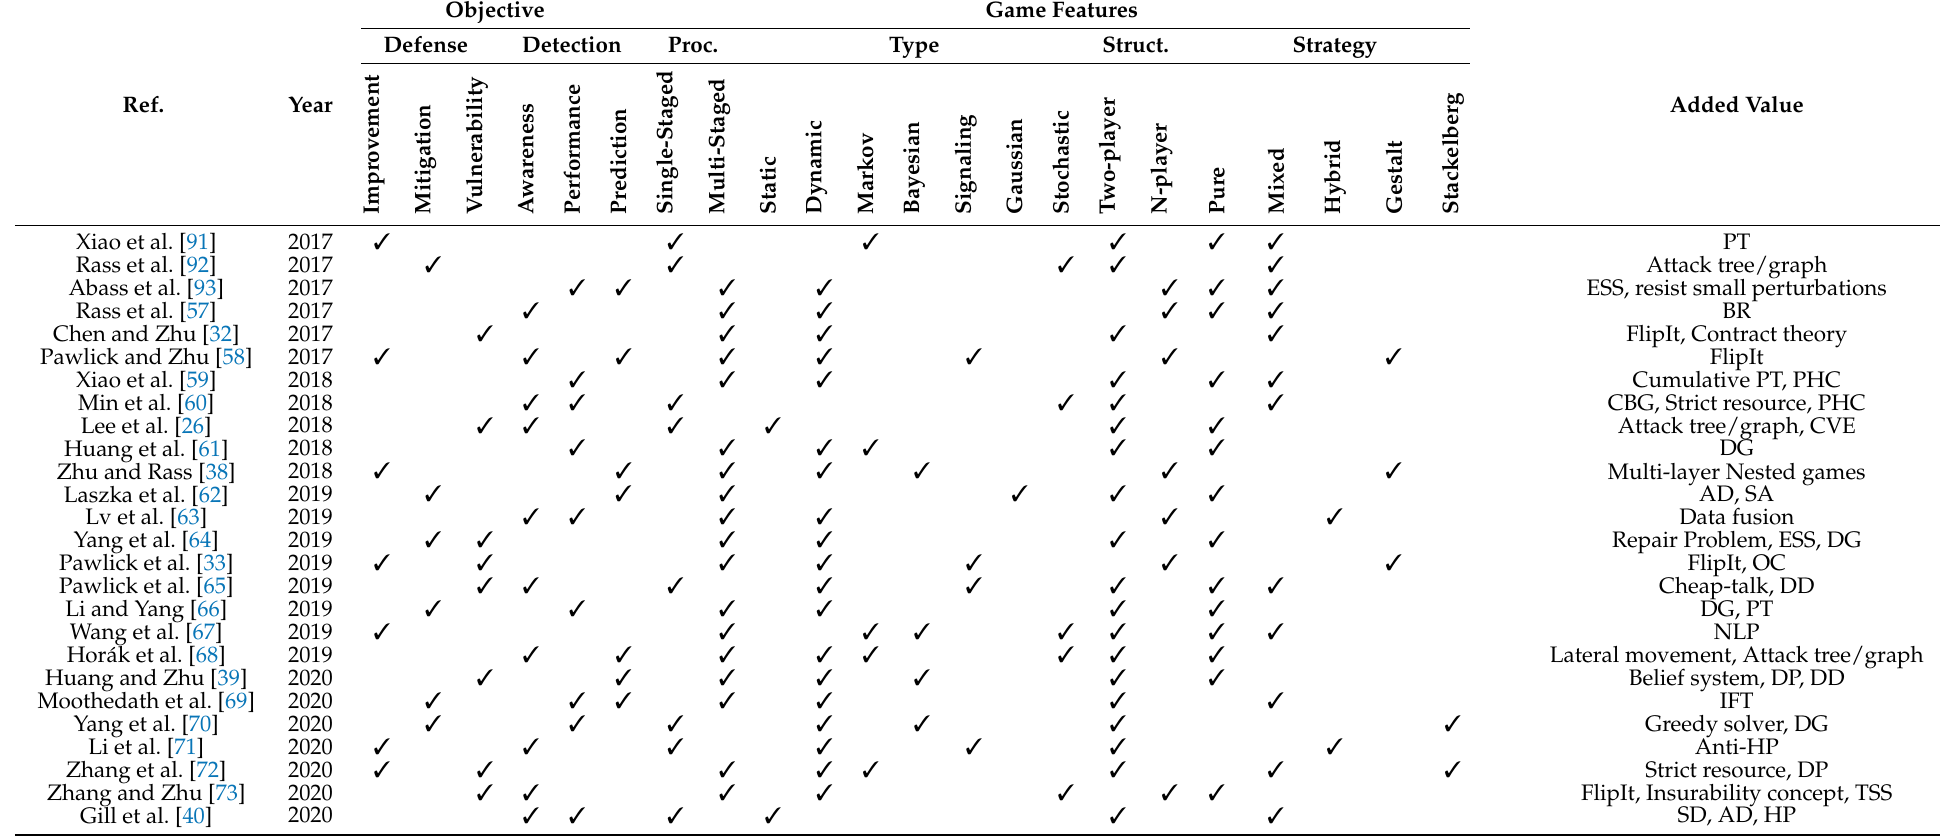
Table 6. Summary of game-theory approaches for APT detection and prevention, aggregated by objectives, game features, and added values. Objective Game Features ValueDefense Detection Proc. Type Struct. Strategy Ref. Year